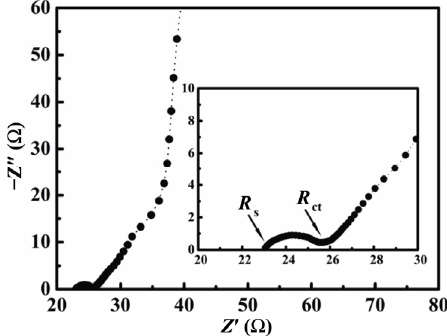
Fig. 7 EIS curves of VN nanofiber-based all-solid-state SCs nitrided at 550 ℃ with LiCl/PVA electrolyte. Inset: EIS curves at high frequency.